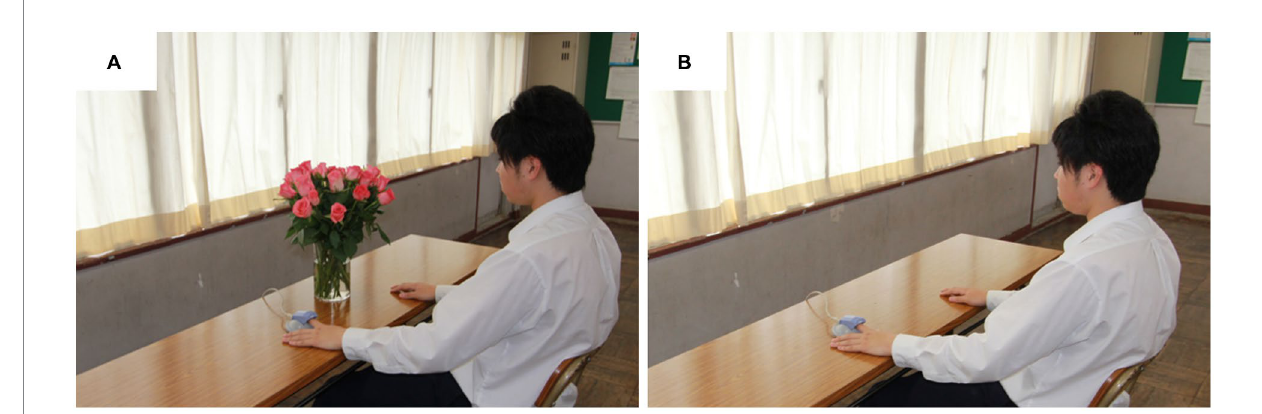
FIGURE 2 Experimental viewing conditions: (A) fresh roses condition and (B) control condition.